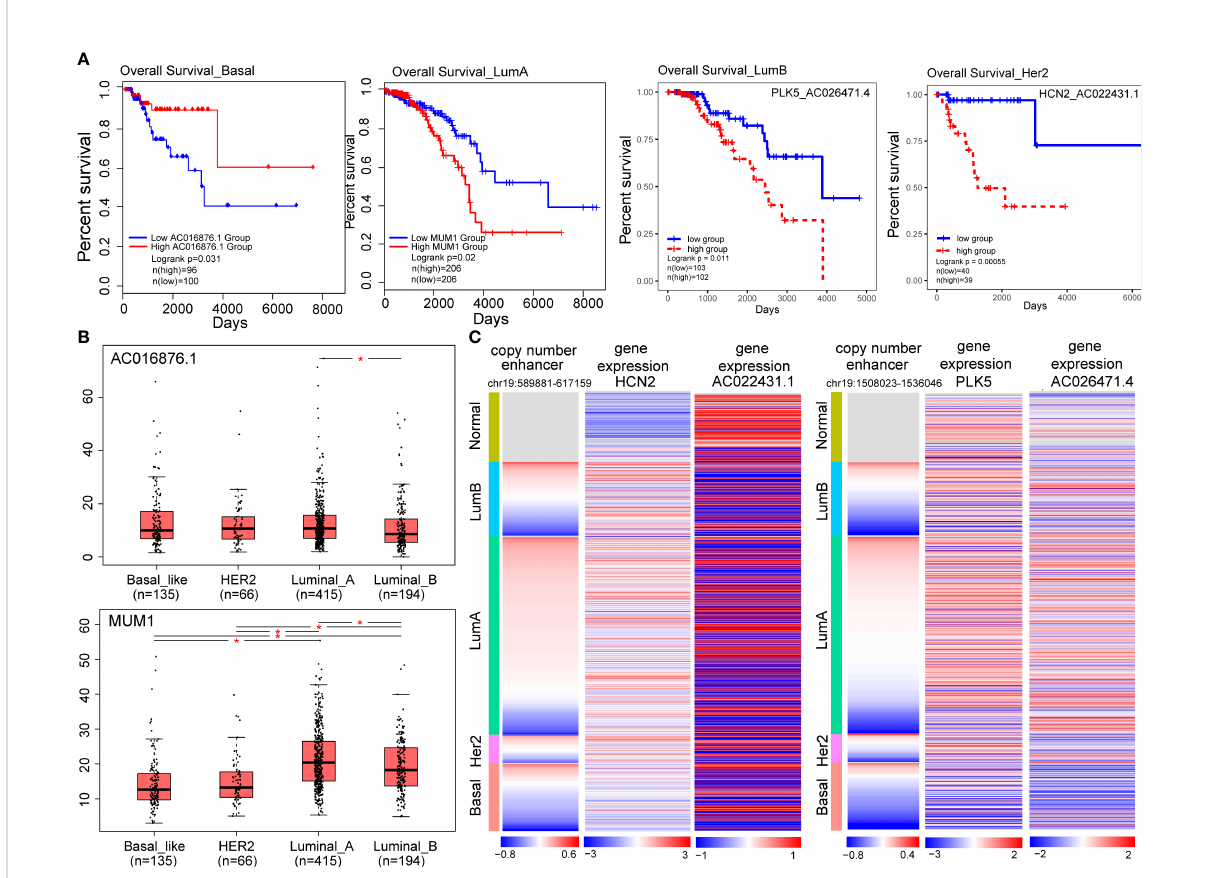
FIGURE 6 Target genes of CNA-driven enhancers elements and lncRNA-mRNA pairs are associated with prognosis in breast cancer subtypes. (A) Kaplan- Meier survival curves according to the gene expression or risk score of lncRNA-mRNA in breast cancer subtypes. The log-rank test was used to estimate the difference in survival time. (B) The differential expression of prognostic markers across the four subtypes using one-way ANOVA. (*p < 0.05). (C) Copy number variation of enhancers (chr19:589881-617159; chr19:1508023-1536046) and expression levels of HCN2, PLK5 and their co-expressed genes in breast cancer